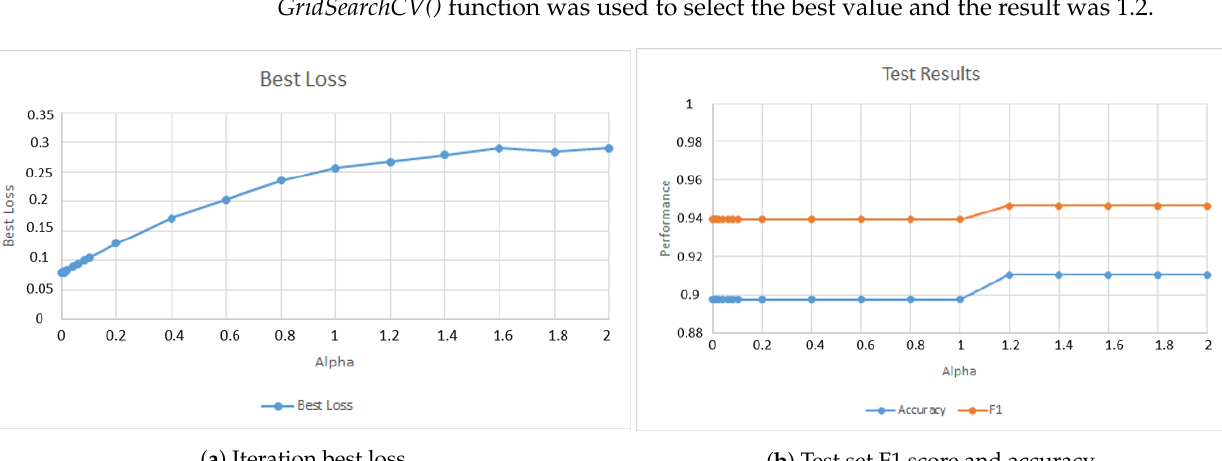
Figure 10. Model performance behavior when changing the value of